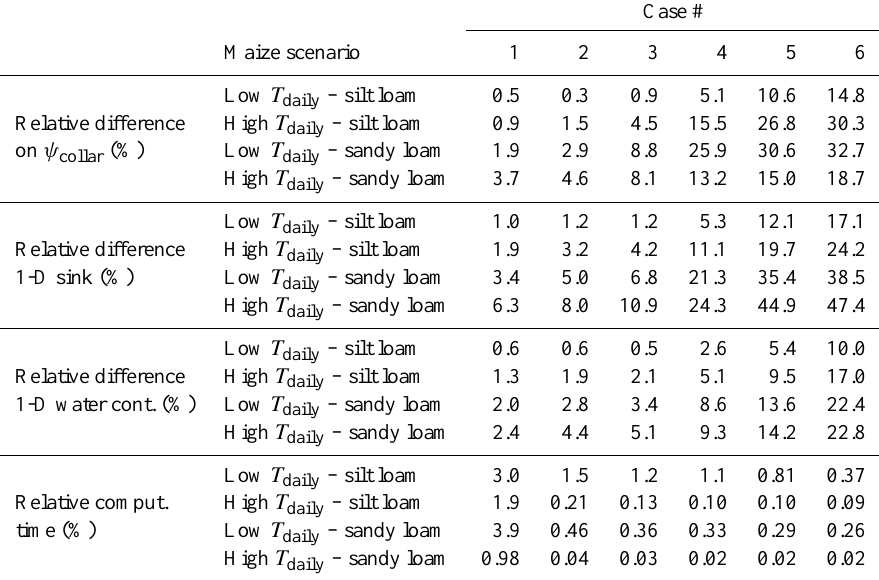
Table 2. Relative absolute differences on ψ collar , 1-D sink terms, 1-D water contents and computing times in the maize scenarios, for increasing soil element sizes. Refer to Table 1 for the detailed geometry of cases